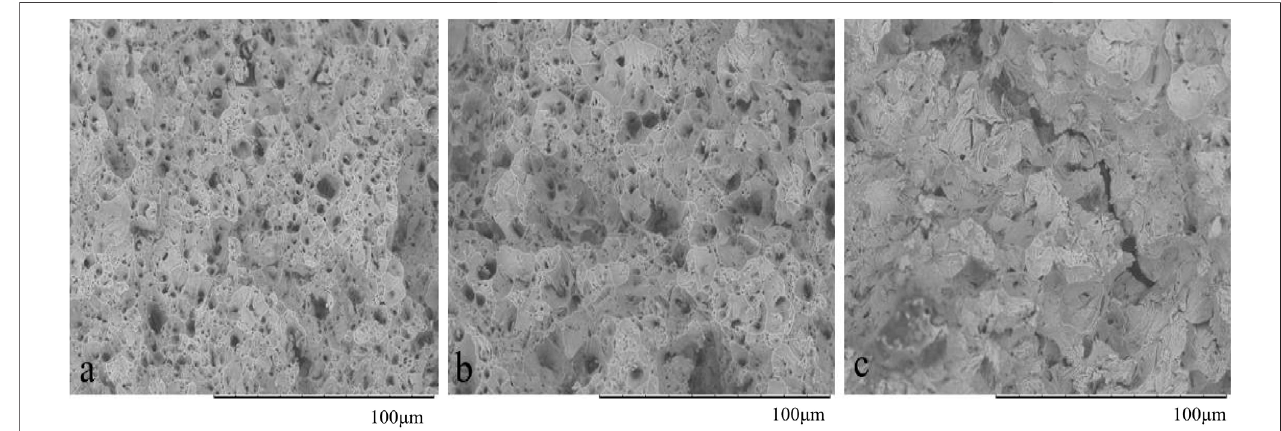
FIGURE 14 | Fracture morphologies of failed Q235 SSRT specimens; a and b are original specimens without treatment stretched in air and 0.2 mol L − 1 NaOH solution; c is specimen stretched in 0.2 mol L − 1 NaOH solution with 1 mA cm − 2 hydrogen charging and stretching at same time.